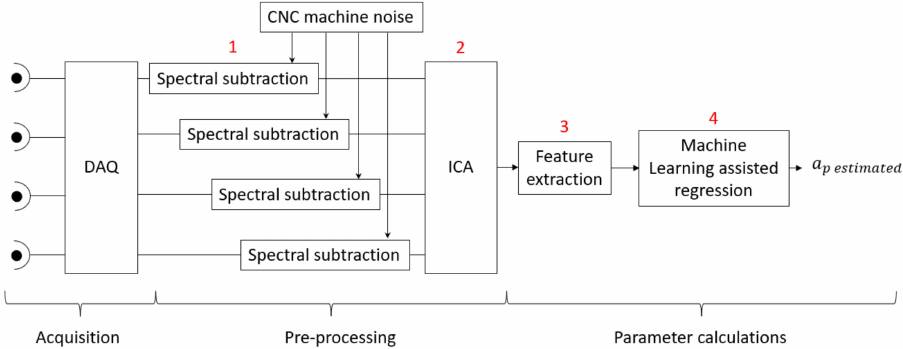
(cid:0) (cid:1) a p